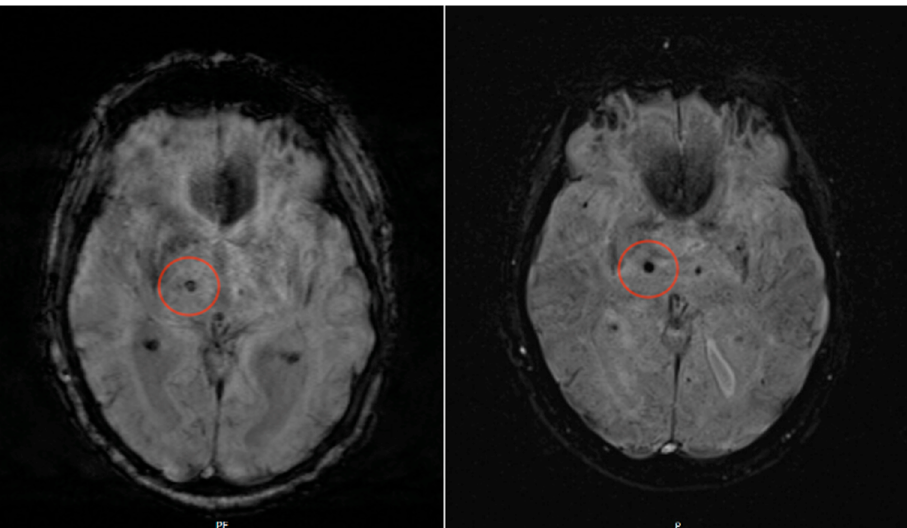
Figure 2. SWI lesion of the right thalamus. In both images (left, axial 1.5 T SWI sequence; right, axial 0.55 T SWI sequence), this lesion is clearly detectable, although it is even better delineated in the 0.55 T dataset.